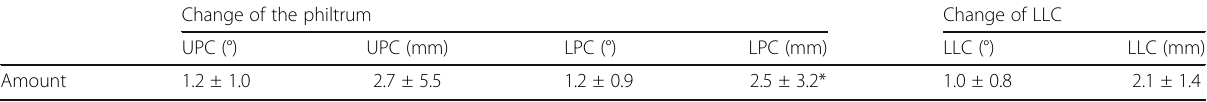
Table 2 Postoperative angular and linear changes of the upper (UPC) and lower philtrum center (LPC) and lower lip center (LLC) Change of the philtrum Change of LLC